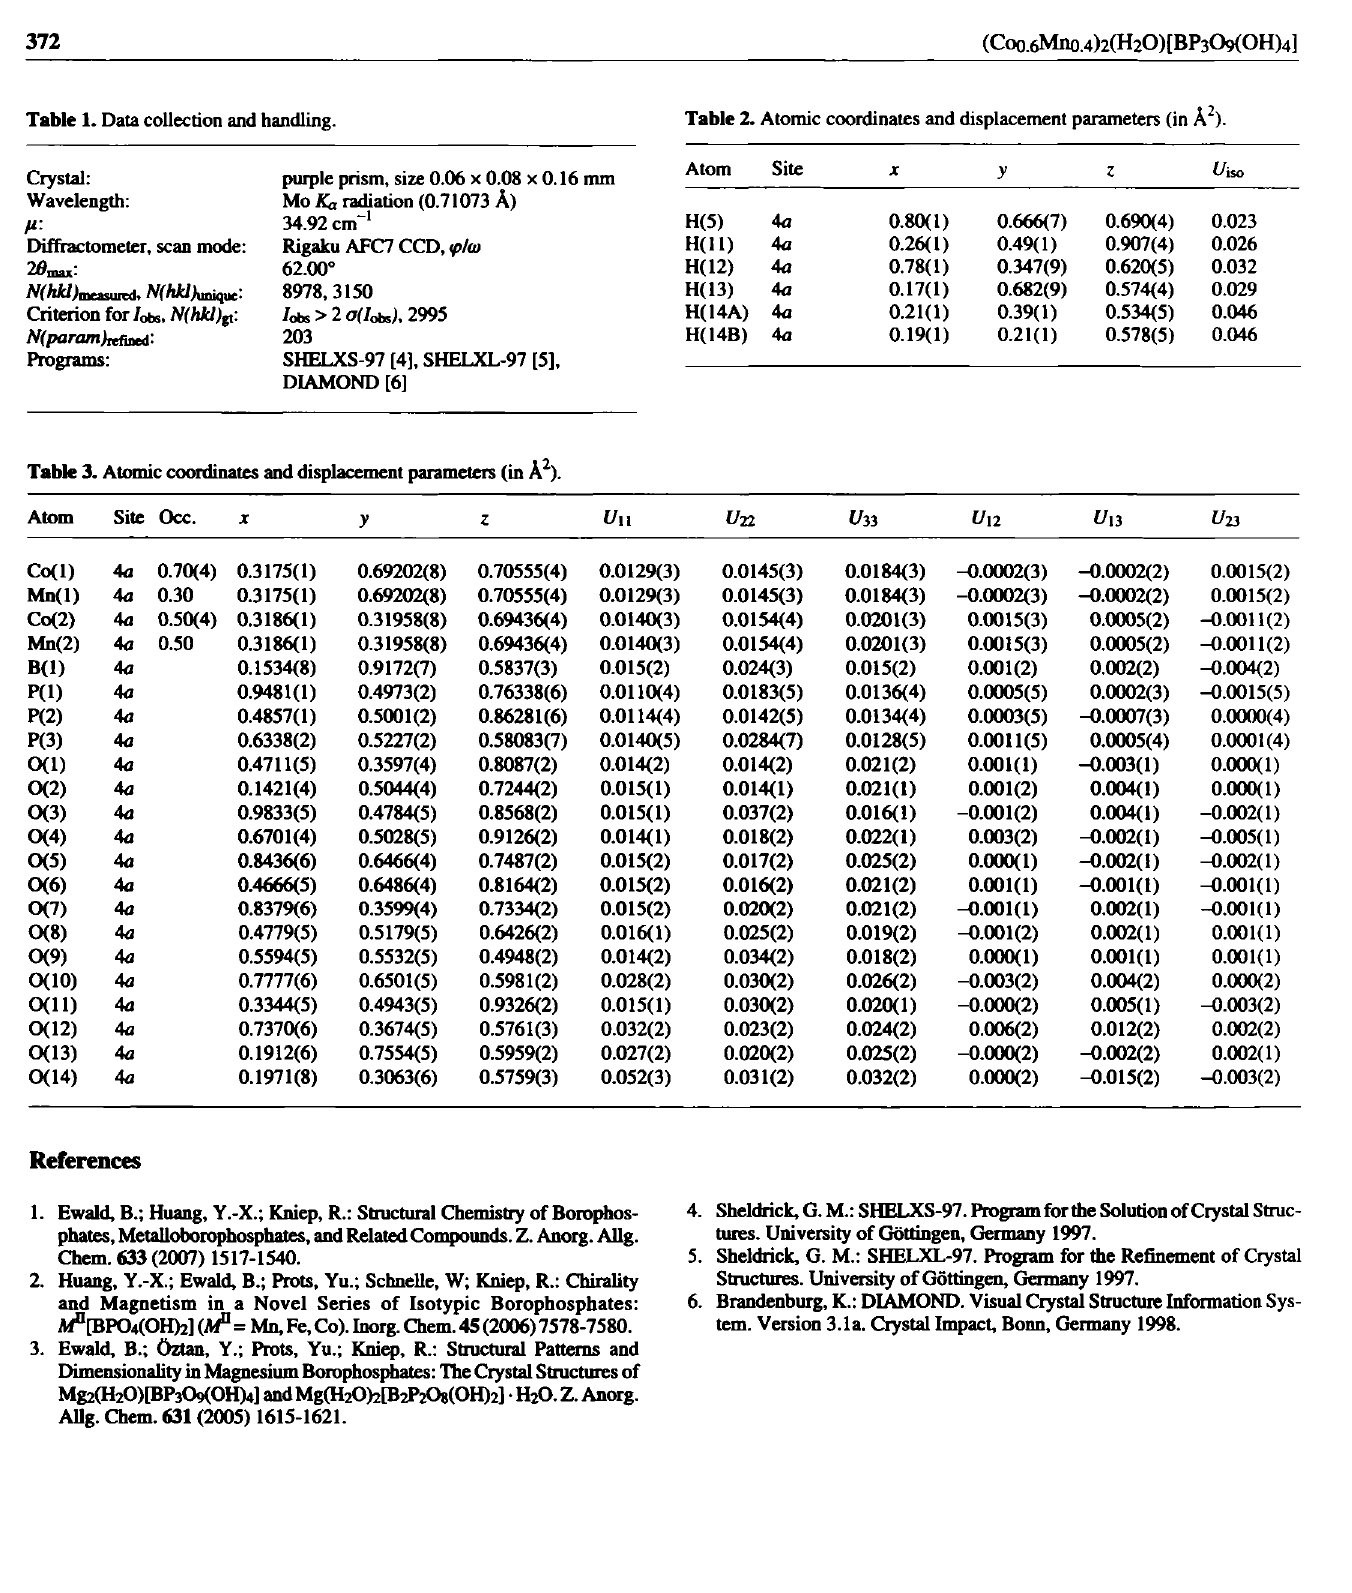
Table 3. Atomic coordinates and displacement parameters (in A 2